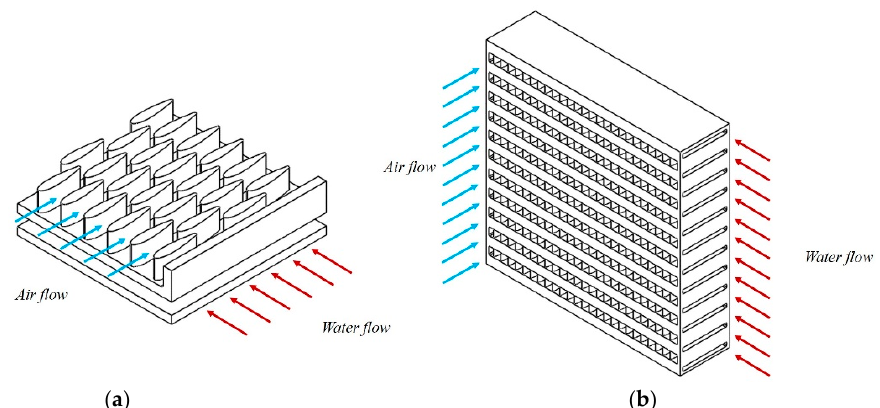
Figure 11. Cross-flow HX configuration displaying ( a ) airfoil pins in the microstructure; ( b ) the overall crossflow HX macrostructure.